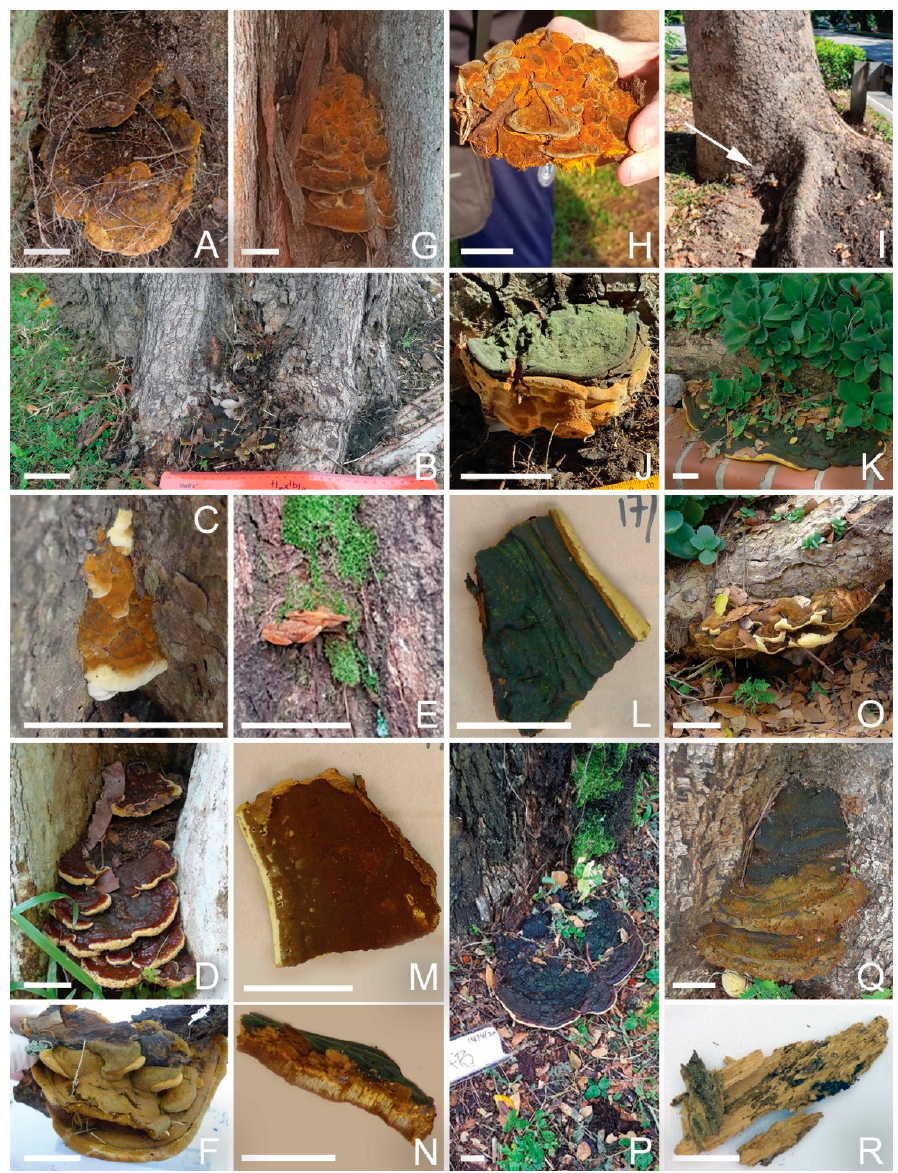
Figure 3. Fulvifomes siamensis detected in Singapore urban trees. ( A ): a fruiting body on a Casuarina